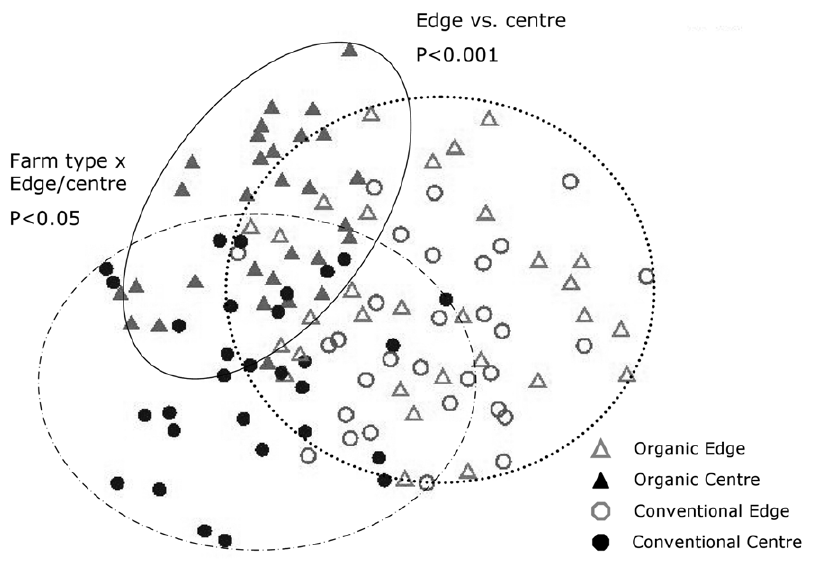
Figure 3. Plant community similarity between organic and conventional edge and centre transects. Illustrated using Non-metric Multidimensional Scaling (MNS with Bray - Curtis index, 2 Axes, 2D Stress =0.21), with significance values obtained using PERMANOVA + . Three distinct plant community groups emerged: organic and conventional edges (dotted line); organic centres (continuous line) and conventional centres (dashed and dotted